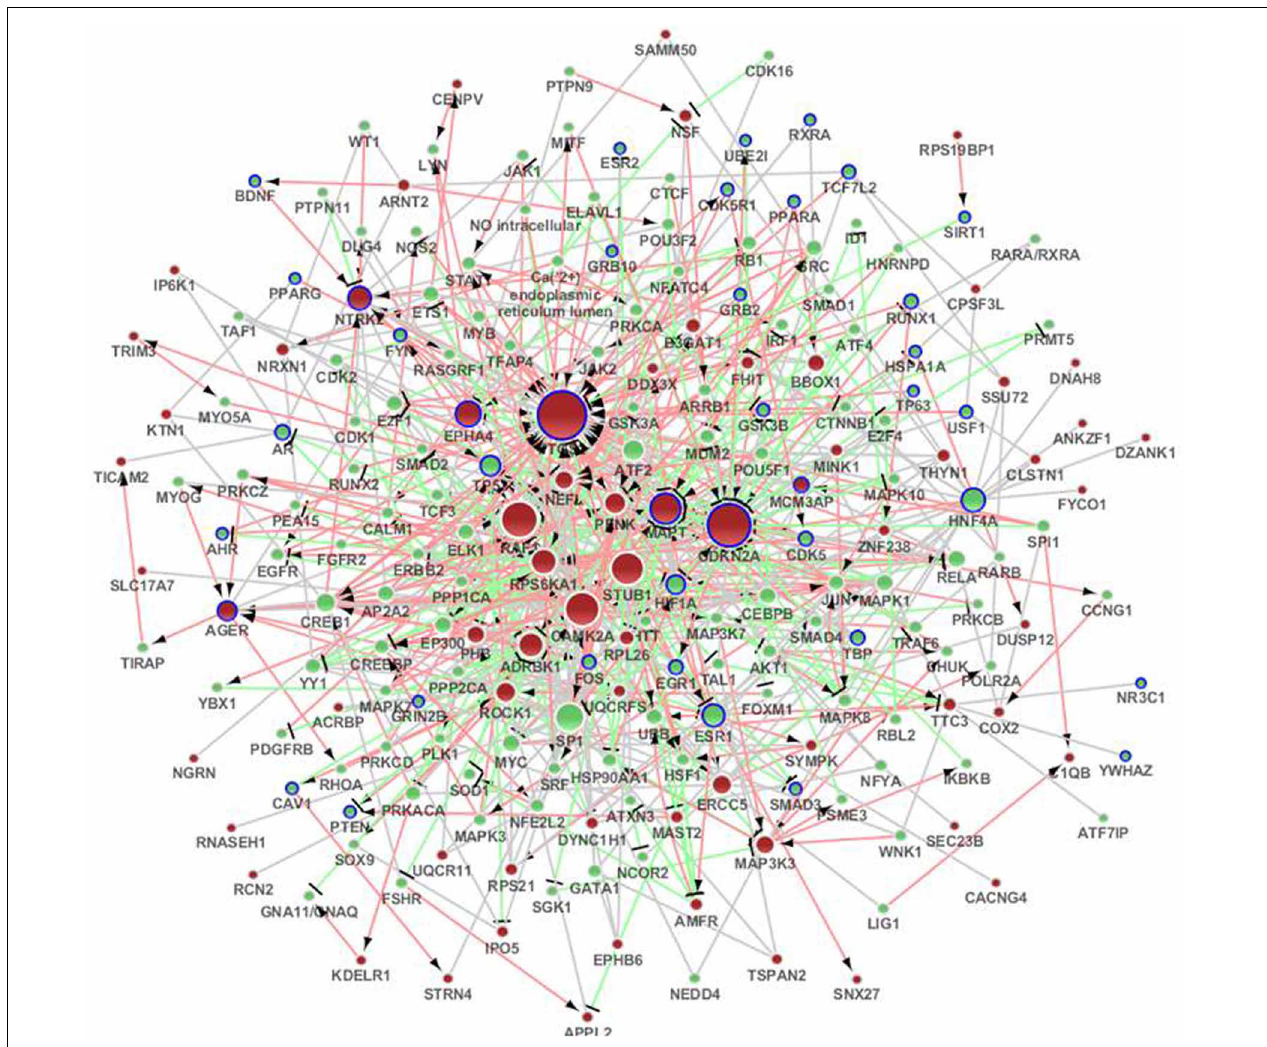
FIGURE 3 | The distinct genetic sub-network of hippocampus and cerebral cortex in SAMP8 mice based on MetaCore network. Red nodes represent differential expressed genes in SAMP8 mice, green nodes are intermediate genes, and genes marked with blue board are AD-related. The size of the node corresponds to the